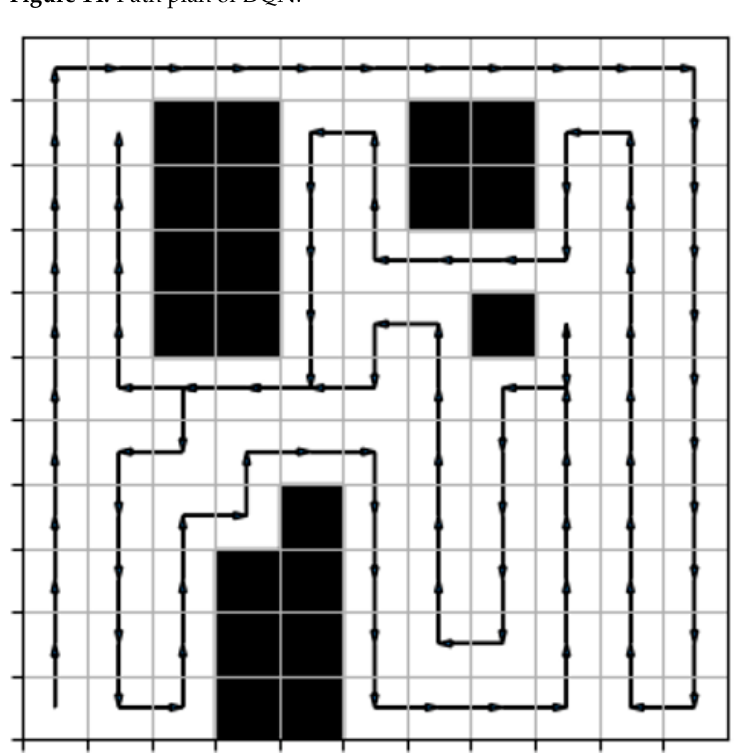
Figure 15. Path plan of improved